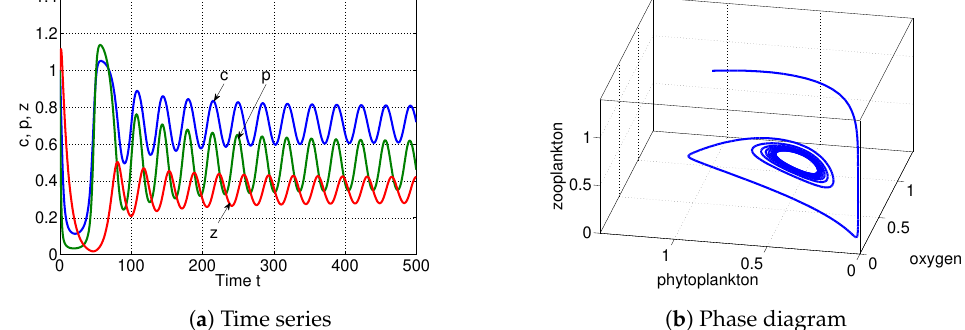
Figure 5. Oscillatory nature of system (1) around of (cid:98) E ( 0.710824,0.473597,0.352043 ) , when A = 2 and the remaining parameters are same as in Figure 4. Initial conditions: c ( 0 ) = p ( 0 ) = z ( 0 ) =